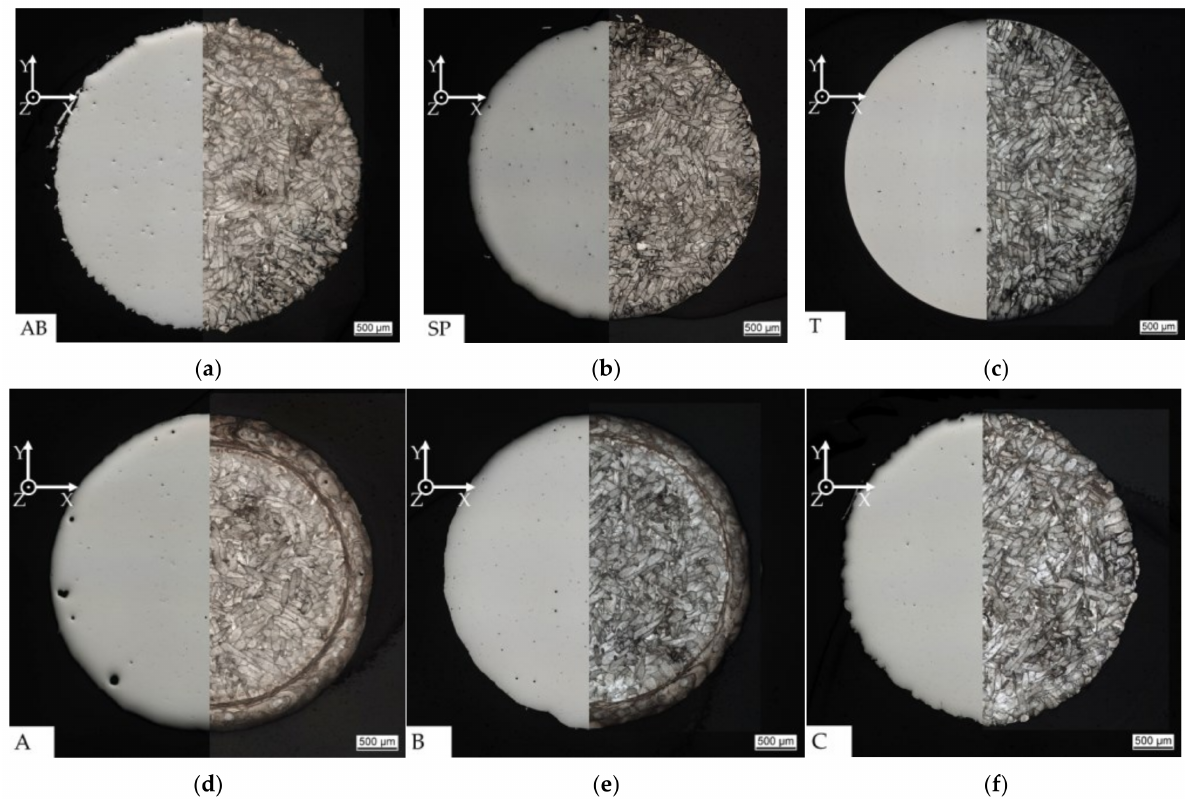
Figure 5. Overview of the metallographic cross sections of the ( a ) as-built-surface AB for comparison and the two post- process-surface states ( b ) shot peened SP, ( c ) turned T, ( d ) contour parameter A, ( e ) contour parameter B, ( f ) contour parameter